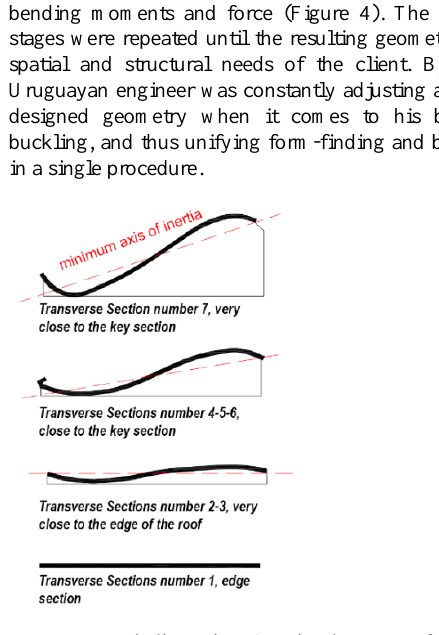
Figure 3: Eladio Dieste’s simultaneous form-finding and behavior analysis procedure starts with successive attempts to adapt the transversal section of the Gaussian Vault to its minimum axis of inertia.